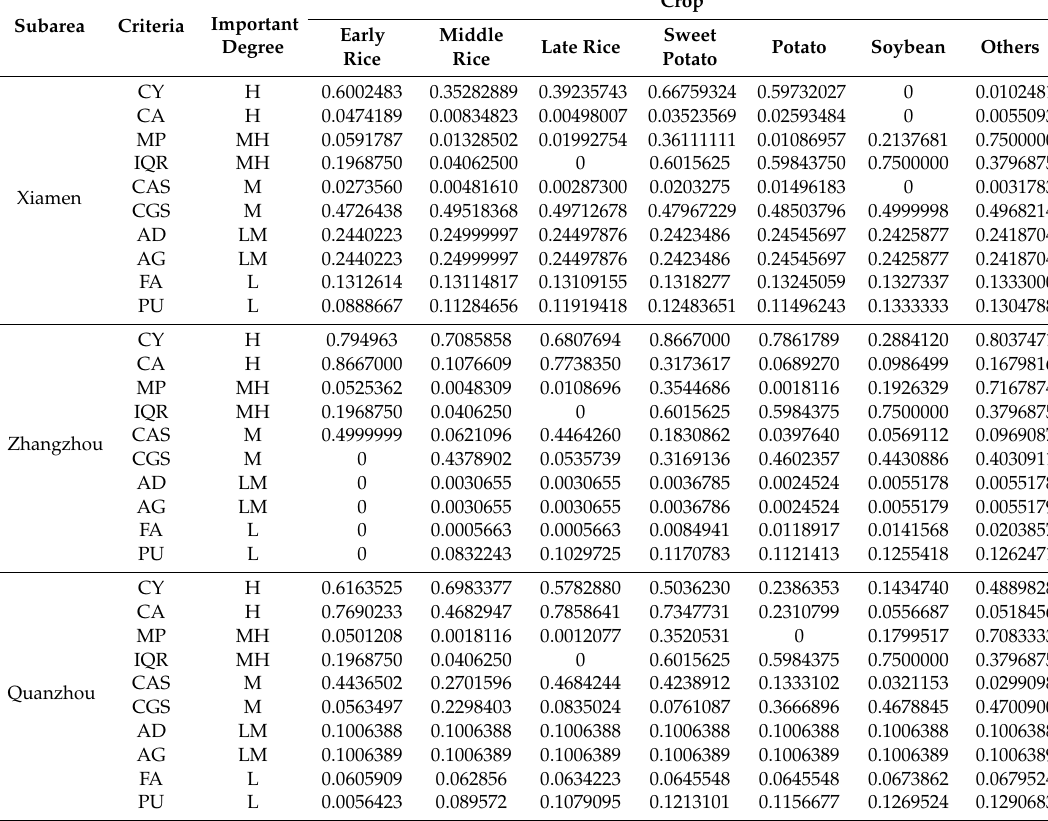
Table 6. New inputs of IF-OWA under α =